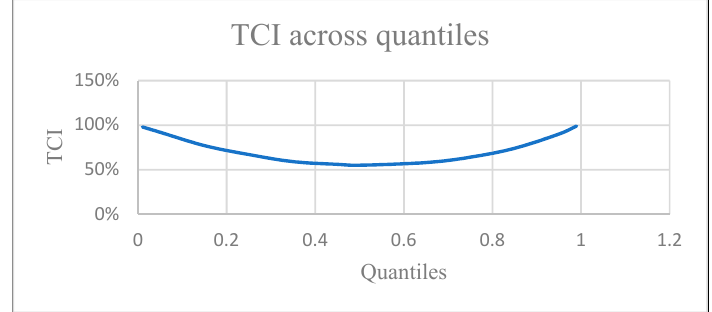
Figure 4. Varying TCI values across quantiles.